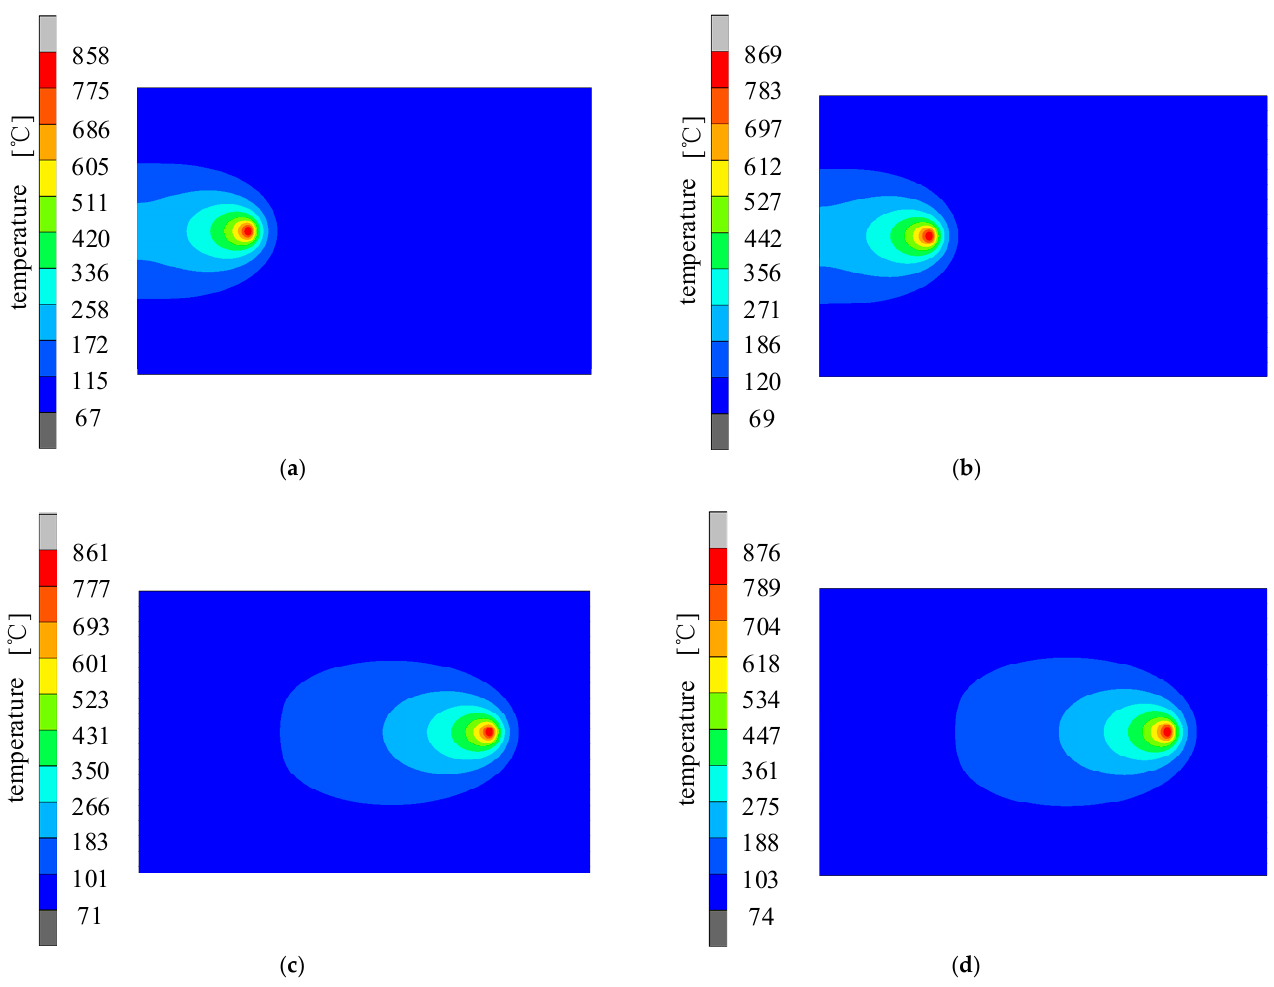
(4) The total heat flow density is: